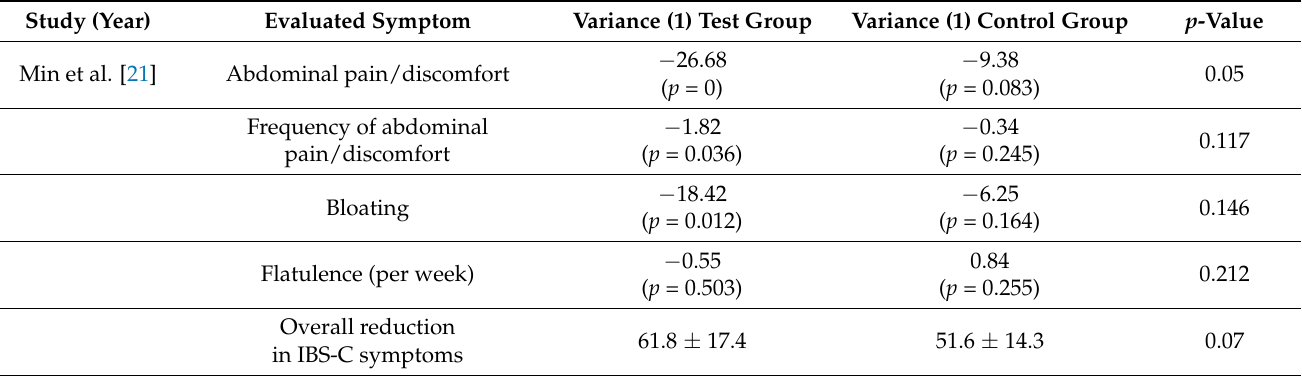
Table 7. Abdominal symptom outcomes for patients suffering from